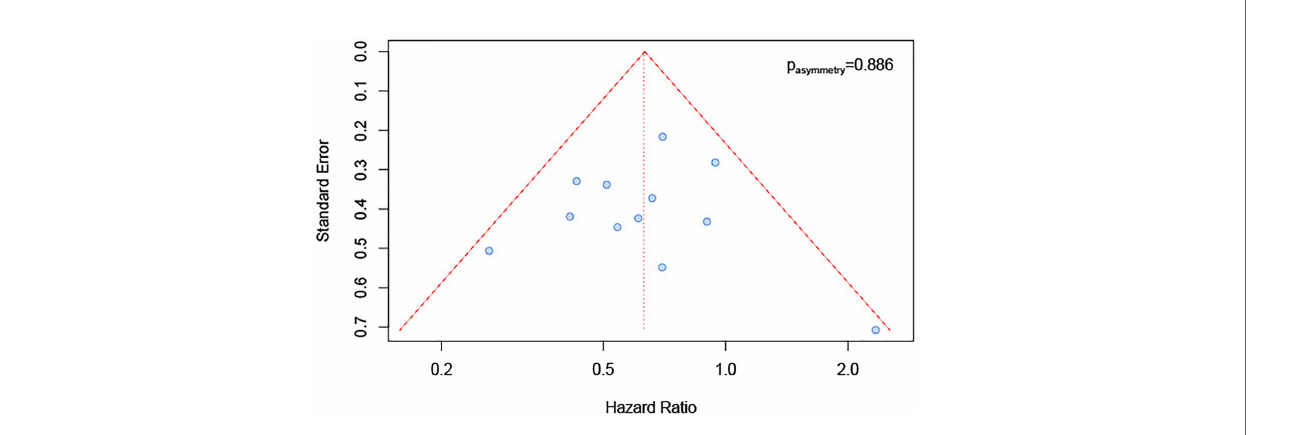
FIGURE 5 | Funnel plot for publication bias.